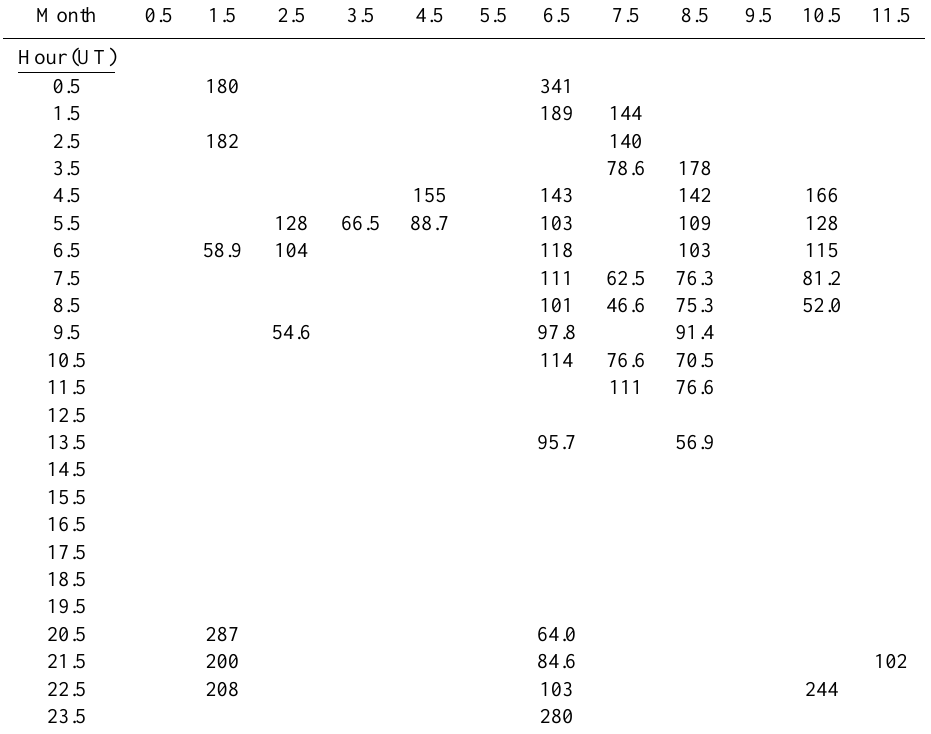
Table A1. Median Electron density at 100km for 1dB absorption